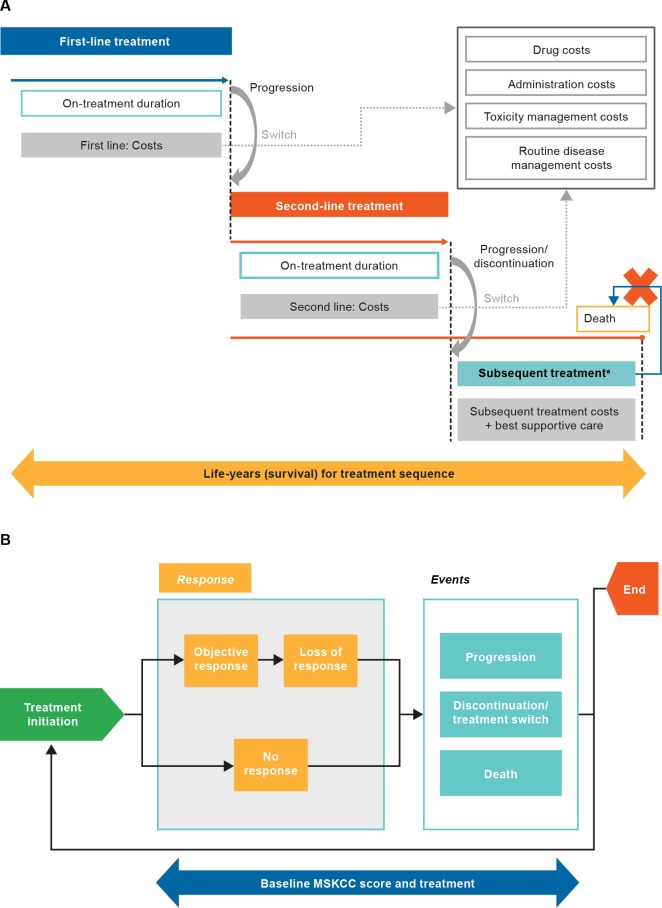
Model flow (A) and structure during first- and second-line treatment (B).
aA mix of rescue therapy patients may receive treatment post second line. This is assumed to have no effect on survival.